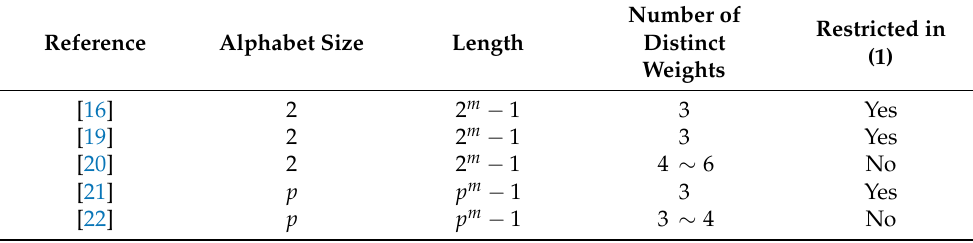
Table 1. Known classes of binary minimal codes ( p is an odd